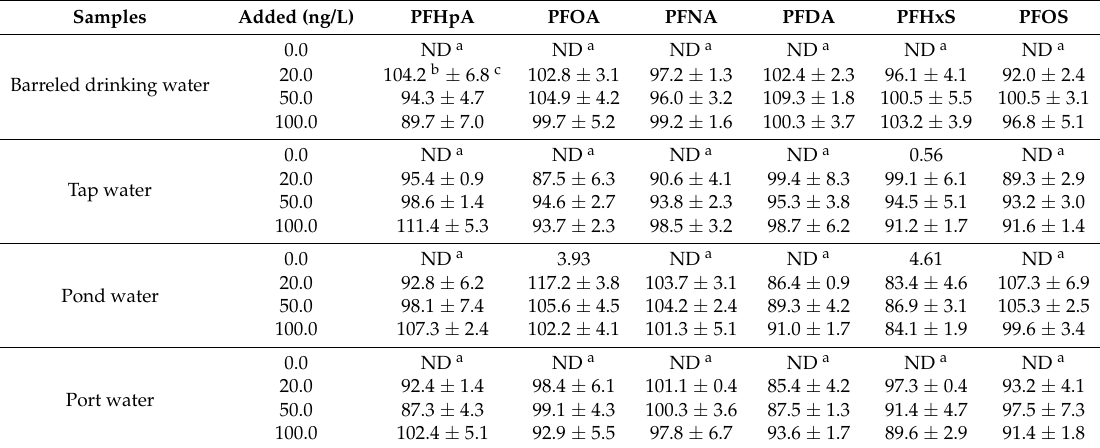
Table 3. Analytical results for the determination of the six PFAAs in real water